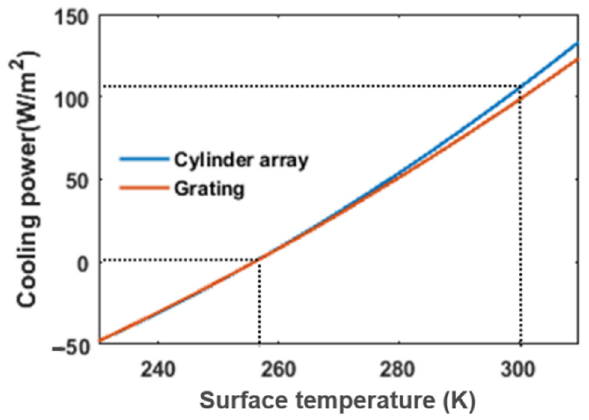
Figure 11. Cooling performance of proposed structures.